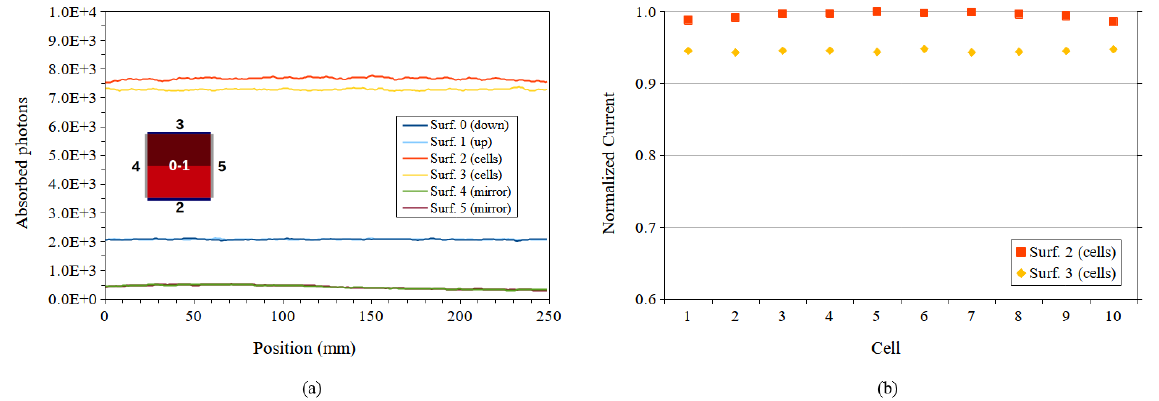
Figure 13. Shaded LSC panel with two 10-cells PV arrays, shading along the PV arrays: ( a ) Number of rays of light collected by the PV cells as a function of the position along the LSC side, which ranges from 0 mm to 250 mm. ( b ) Normalized current produced by each PV cell.